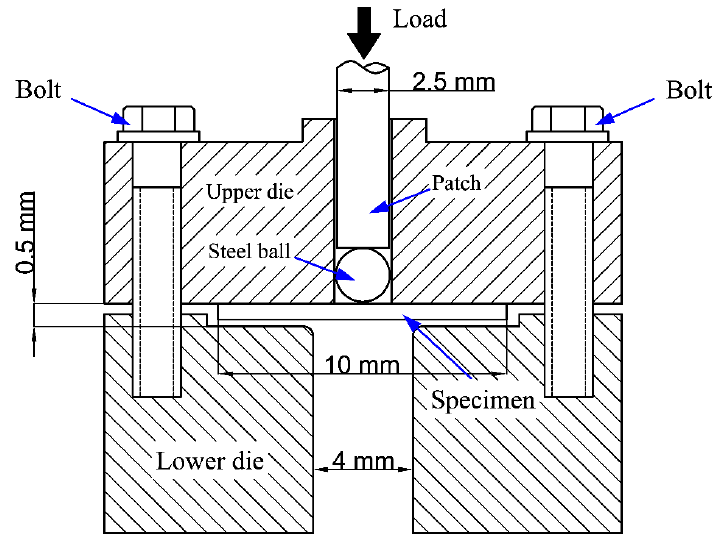
Figure 1. The schematic of the small punch test (SPT) device.